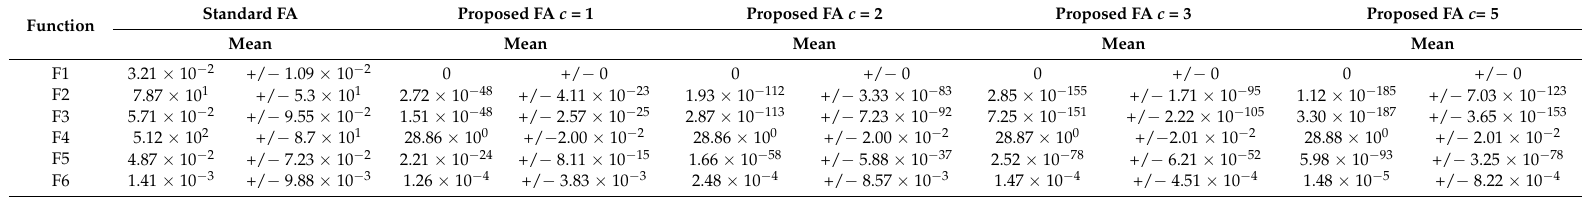
Table 5. Results obtained by the standard FA and the proposed FA with different values of c on the test suite.